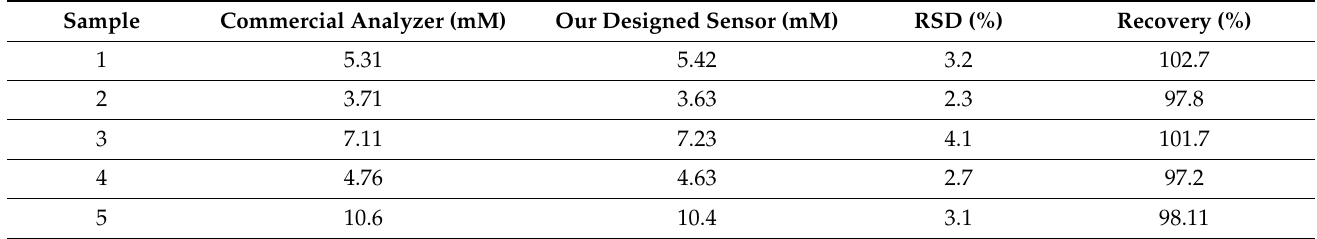
Table 2. Detection of glucose in real human serum (n =